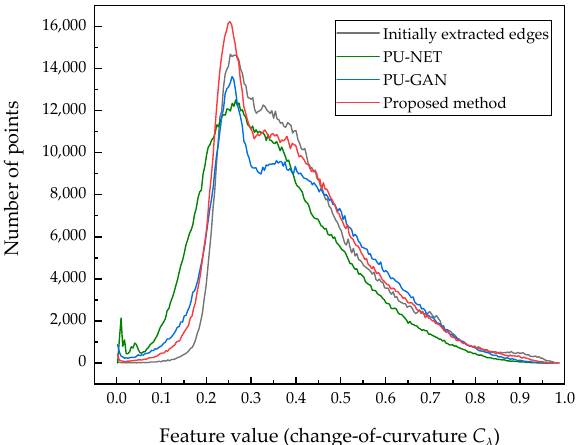
Figure 15. Frequency distribution of the point number with respect to the feature value (change-of- curvature C λ ) for the initially extracted edge points and the upsampled edge points by using the three